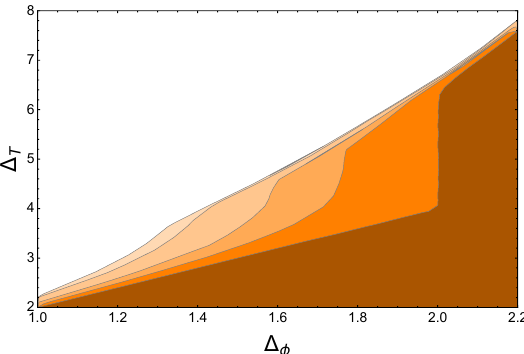
Figure 2: Bounds on ∆ (the scaling dimension of the leading scalar operator in T the rank-2 symmetric traceless tensor representation of O ( N ) ) in terms of ∆ φ of 3d CFTs with O ( 16 ) , O ( 20 ) , O ( 40 ) , O ( 100 ) , and O ( ∞ ) global symmetries (from left to right). Shaded regions are consistent with bootstrap constraints, therefore allow unitary CFTs to